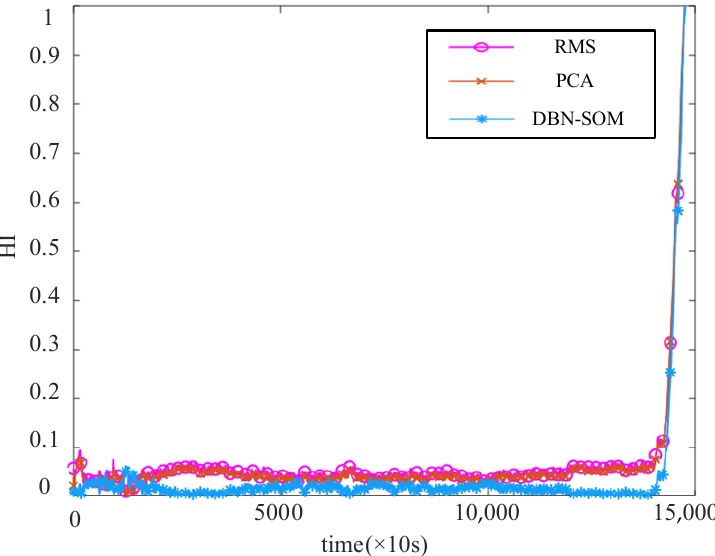
Figure 9. HI curve of bearing3_1 for RMS method, PCA method, and DBN-SOM method.